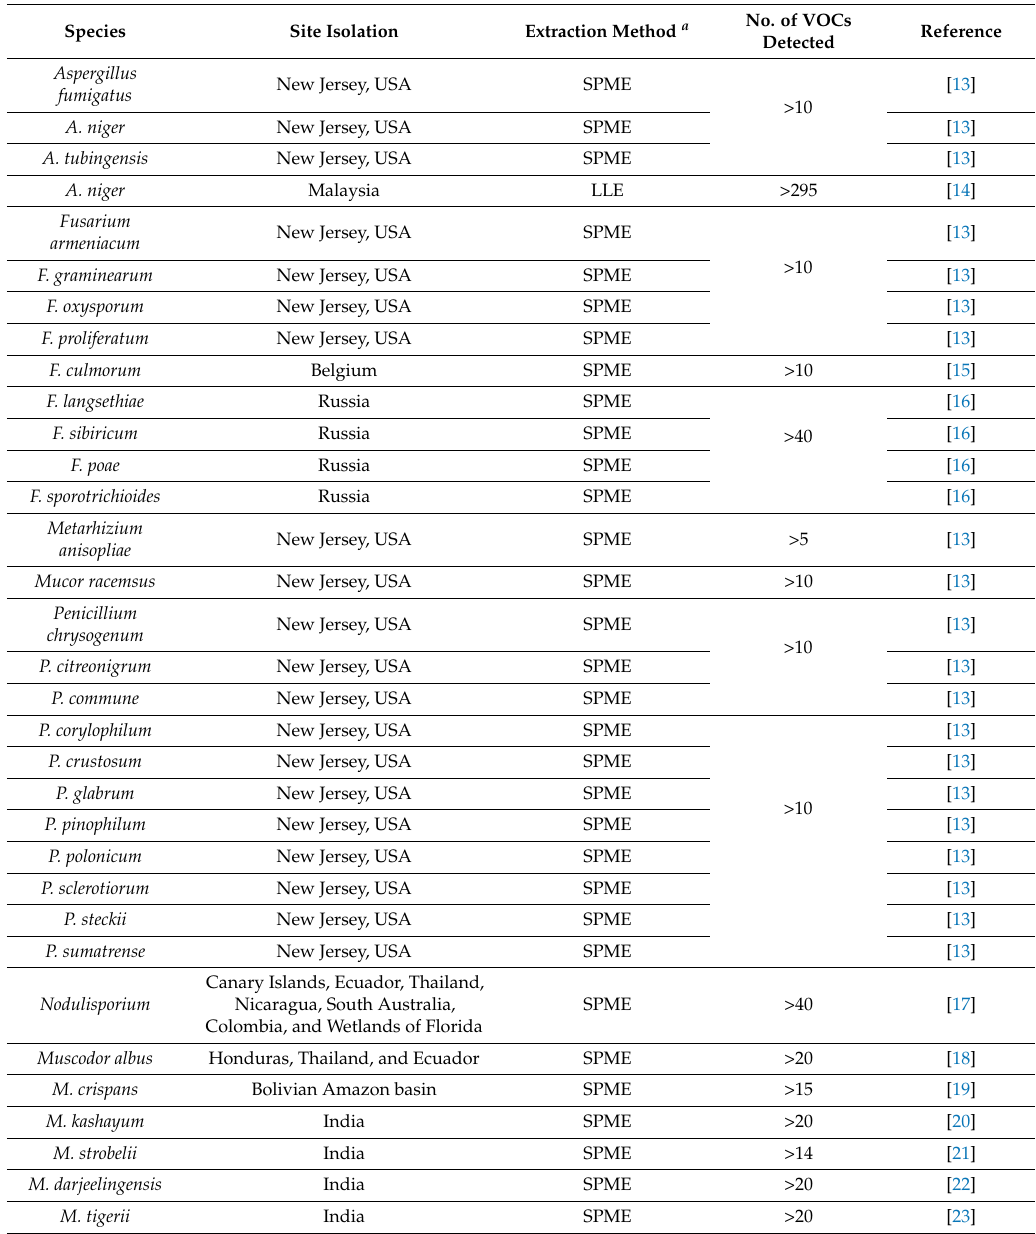
Table 1. A list of fungi presently known to produce volatile organic compounds.